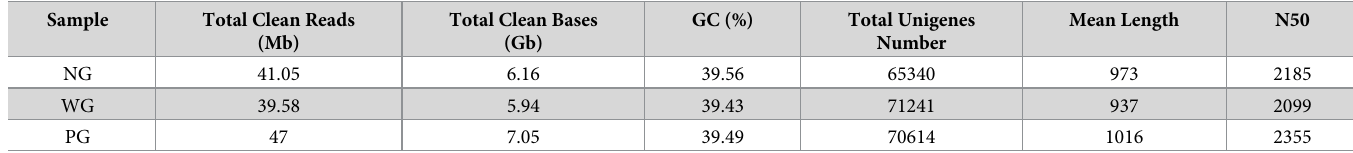
Table 1. Summary of sequencing reads after filtering and quality metrics of unigenes. NG (negative control group), WG (WSSV-infected group) and PG (poly I:C challenge group). Sample Total Clean Reads (Mb)